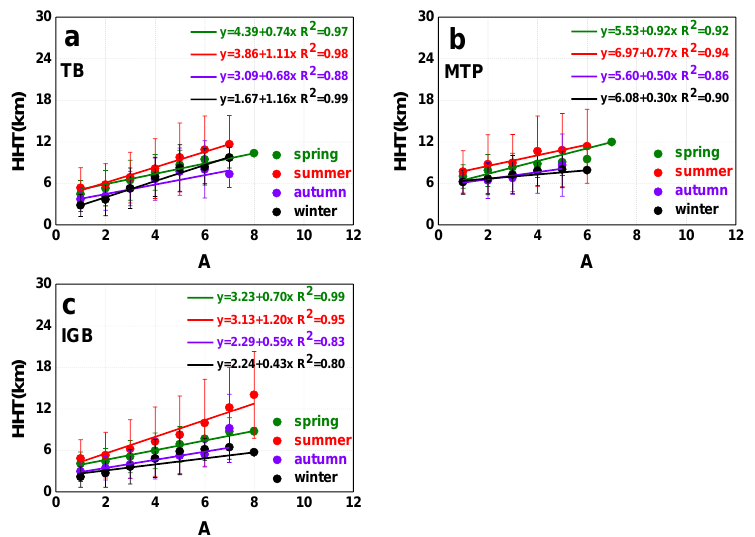
Figure 12. The correlations between height of the highest aerosol layer top (HHT) and layer amount (A) over TP. ( a ) is for TB, ( b ) for MTP, and ( c ) for IGB.